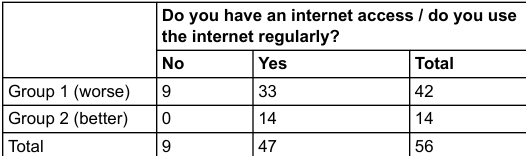
Table 8: Explanation of error in table 7.